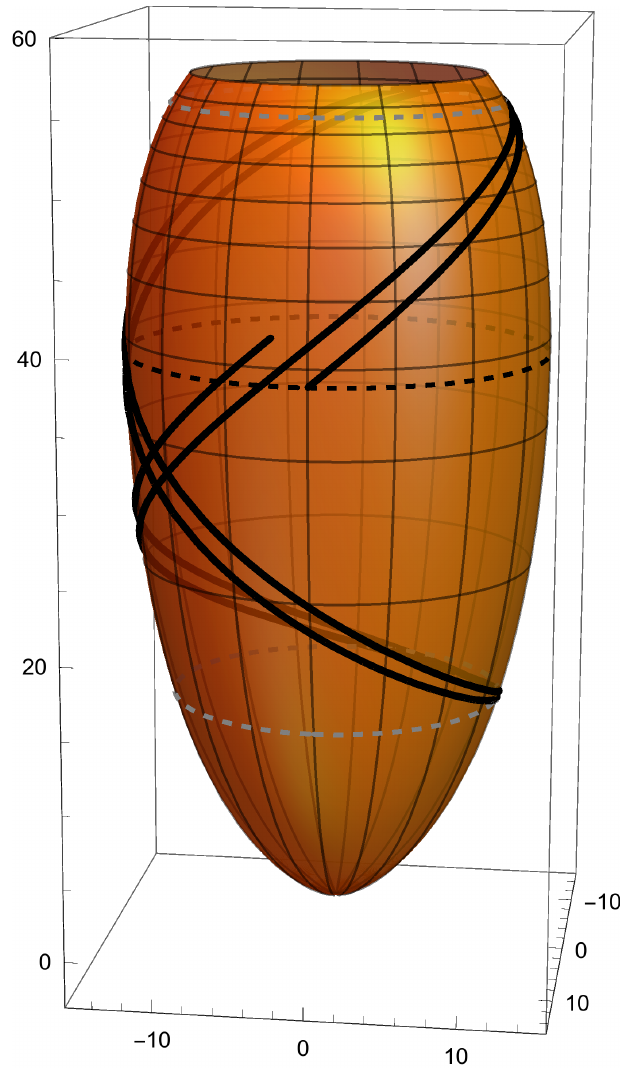
Figure 12. Retrograde geodesic with turning points at r t = 10.875. This goedesic starts as northbound at the equator, marked by a black-dashed latitude. Two more crossings of the equator are shown, each lagging behind by a negative shift of ∆ φ = − 0.2118. A = 525.6 and B =